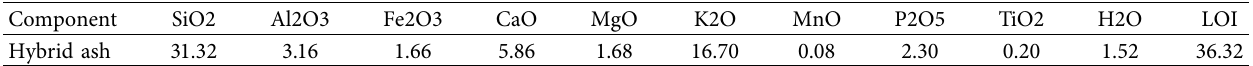
Figure 1: (a) Coffee husk ash and (b) sugarcane bagasse ash. Table 1: Major and minor oxides of hybrid of CHA and SCBA.